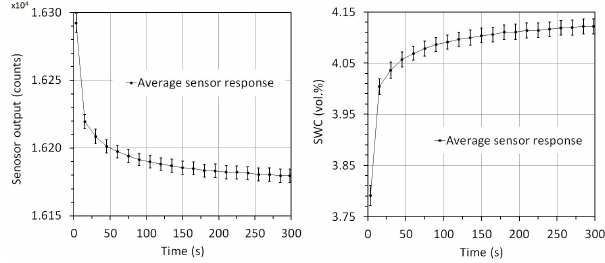
Figure 5. Results of the compaction experiment with glass beads packing (left and right panels present the raw sensor output and equivalent SWC calculated with the Topp equation [36], respectively).